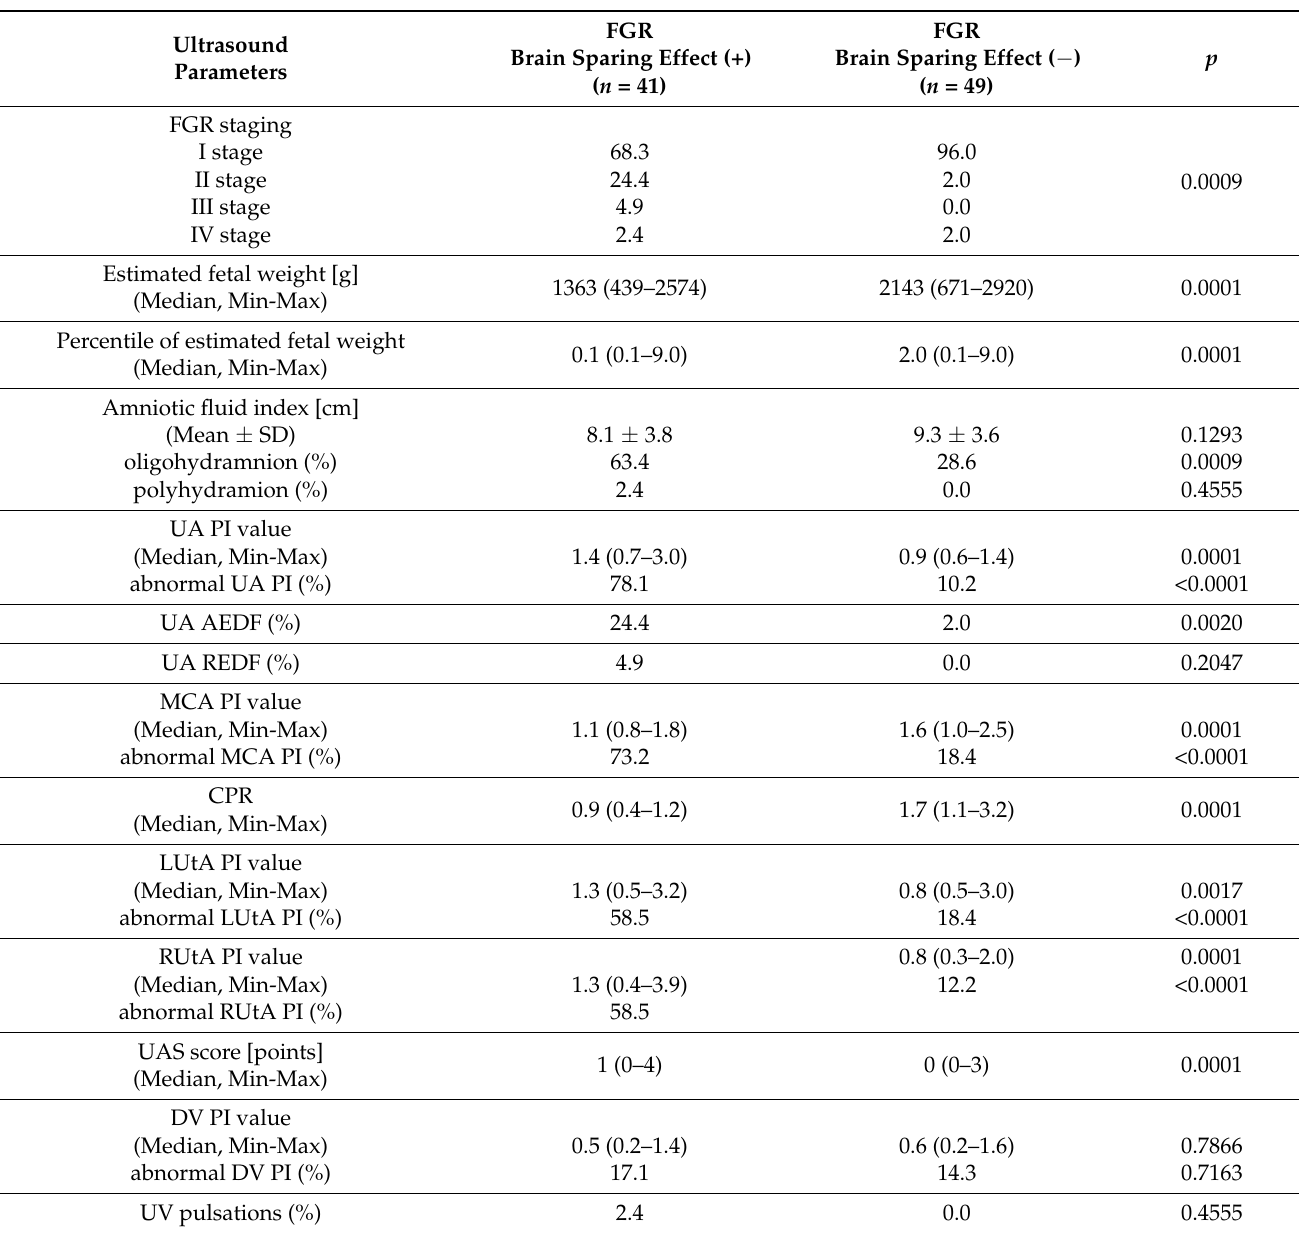
Table 2. Ultrasound examination results in a FGR pregnancy in the presence or absence of the brain sparing